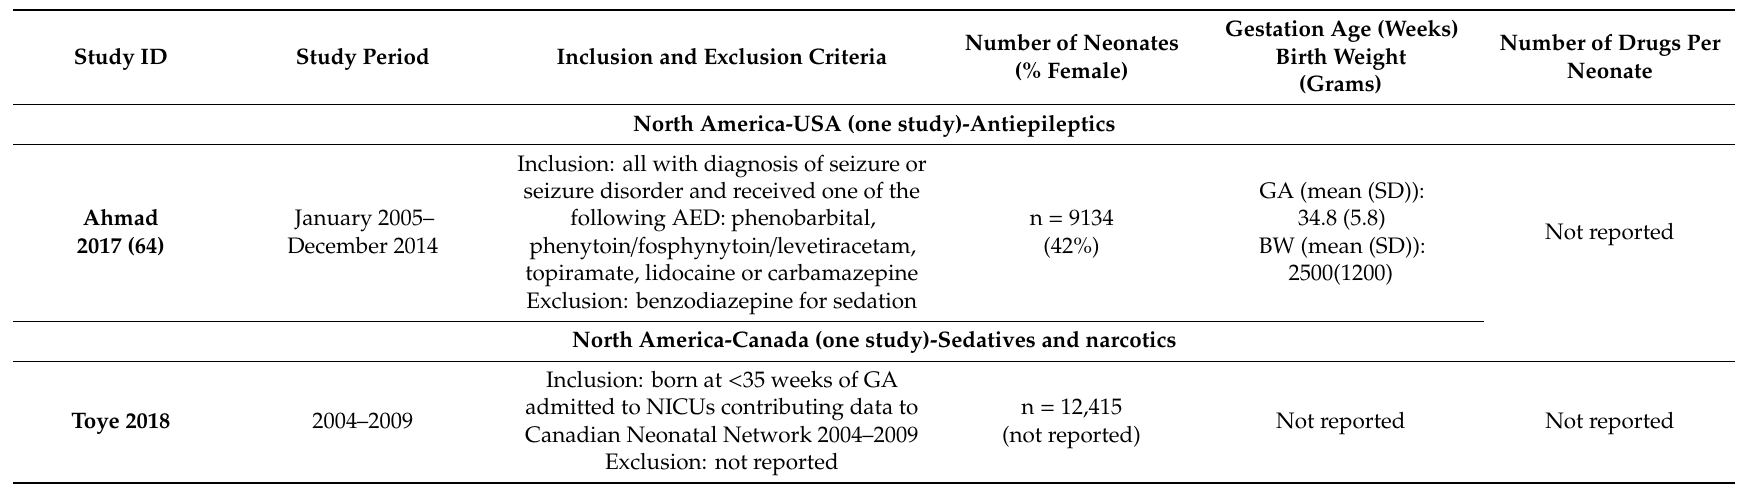
Table A10. Studies of drug utilization on specific pharmacologic groups only (5